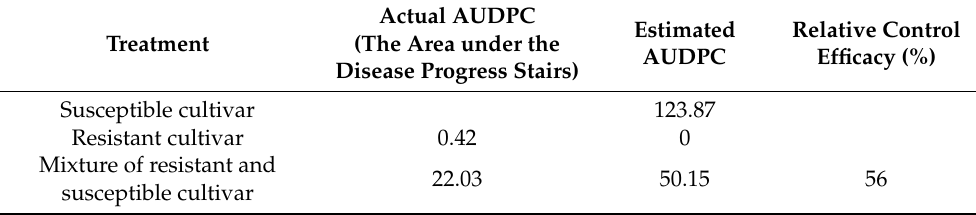
Table 1. Rust disease